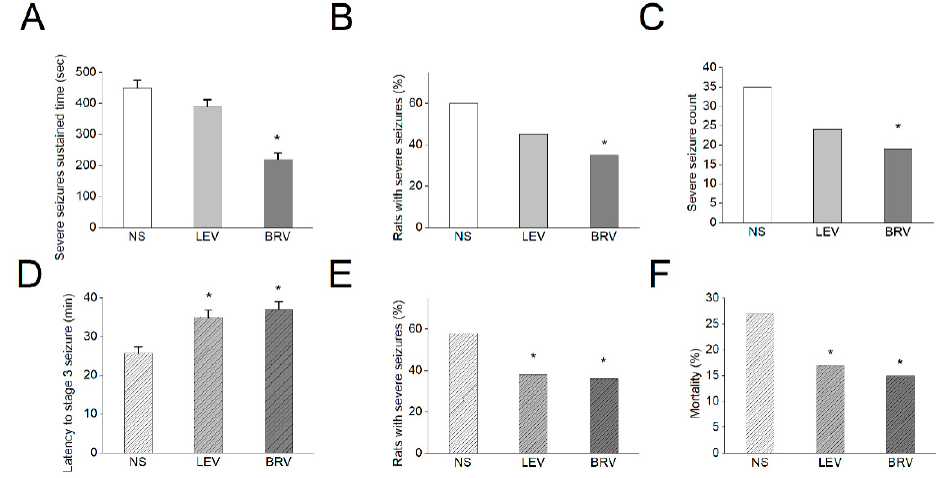
Figure 10. Effects of BRV versus LEV on acute seizures in OD-1 and lithium-pilocarpine animal models. ( A – C ) In the OD-1 model, BRV had a significant effect on the sustained time of severe seizures (stage 4 and above) compared to the control group. The BRV group also had a low number of rats with severe seizures and a lower severe seizure count, as compared to the control group (* p < 0.05, n = 7 in each group); ( D – F ) In the lithium-pilocarpine-induced epilepsy model, compared to the control group, both LEV and BRV had significant effects on the latency of stage 3 seizures, the number of rats with severe seizures, and mortality (* p < 0.05, n = 7 in each group). The data were analyzed using an ANOVA followed by Fisher’s least significant difference tests.